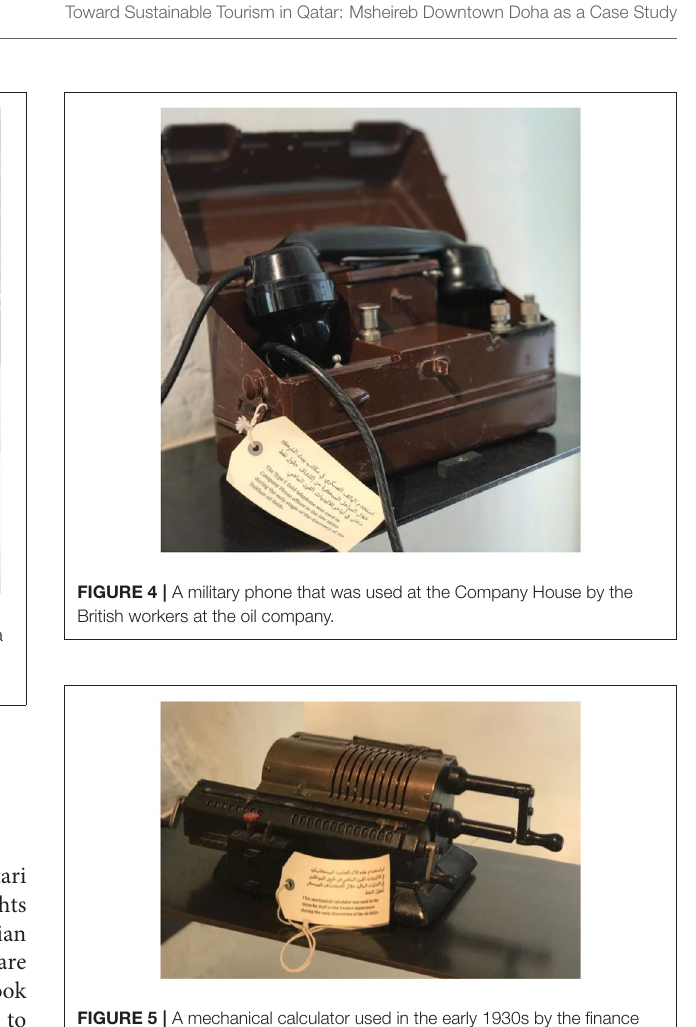
FIGURE 5 | A mechanical calculator used in the early 1930s by the finance